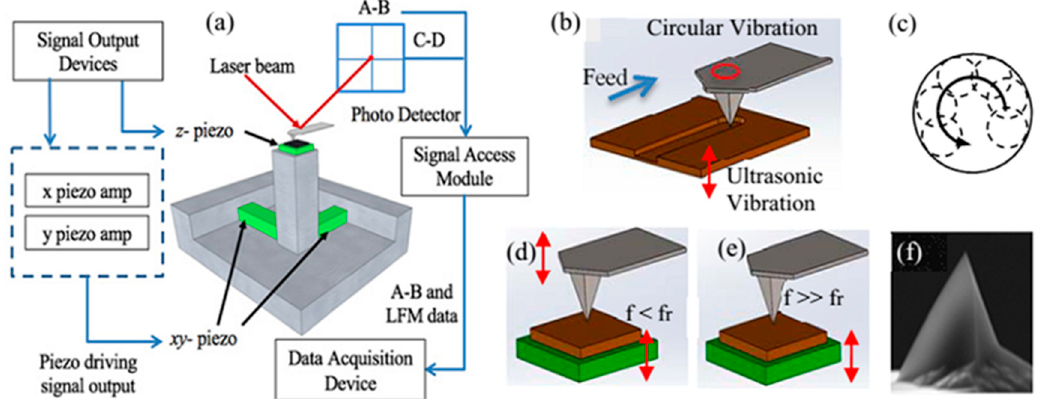
Figure 12. The schematic diagram of the vibration-assisted method: ( a ) modified AFM system, ( b ) the diagram of machining, ( c ) the circular path of the tip, ( d ) tip vibrates without ultrasonic, ( e ) tip vibrates with ultrasonic, ( f ) the SEM image of the tip used in this method [90] .